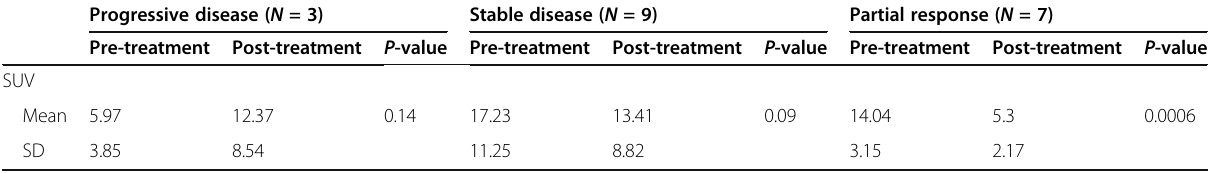
Table 5 Comparison of baseline and post-treatment SUV in PD, SD, and PR groups Progressive disease ( N = 3) Stable disease ( N = 9) Partial response ( N = 7)